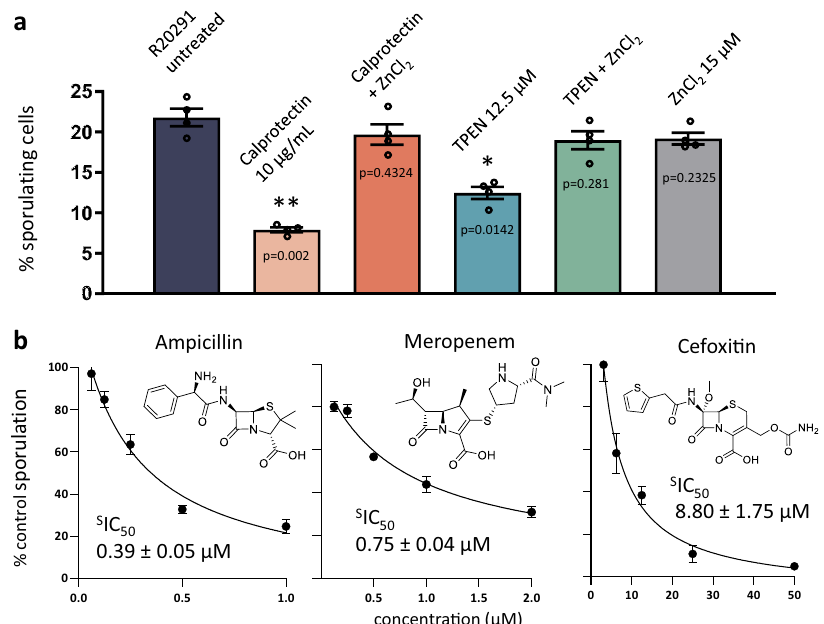
Fig. 6 | Zn 2+ -chelating agents TPEN, calprotectin, and all classes of β -lactams disruptC.dif fi cilesporulation.a Anti-sporulationeffectsofthechemicalchelator TPEN and the biological chelator calprotectin, an innate immune system protein. This inhibition can be reversed through restoring growth media with Zn 2+ . Four biologically repeats were performed. Data between two groups were analyzed by student ’ s unpaired t -test for statistical signi fi cance. Data are expressed as mean± SEM. Differences were considered statistically signi fi cant if p <0.05 (*) vs R20291, p <0.01 (**) vs R20291, and nonsigni fi cant where undesignated. b All three major